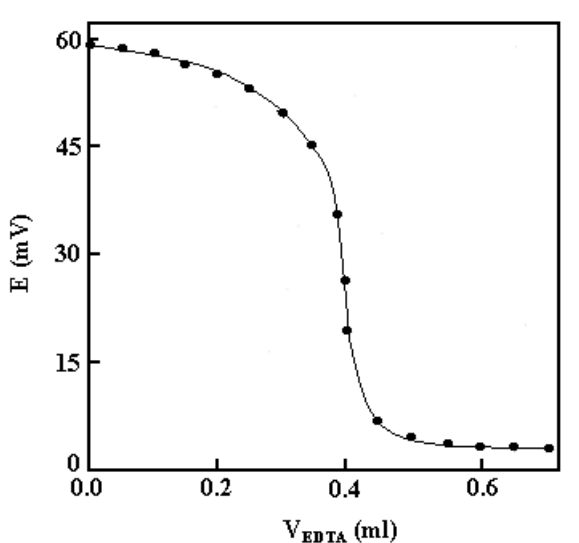
Figure 4. Potentiometric titration curve of 40 ml of 0.001 M Sr(NO EDTA at pH 6.5, using the proposed sensor as indicator